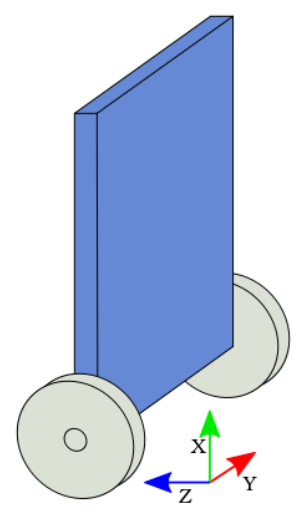
Figure 4. Self-balancing robot orientation